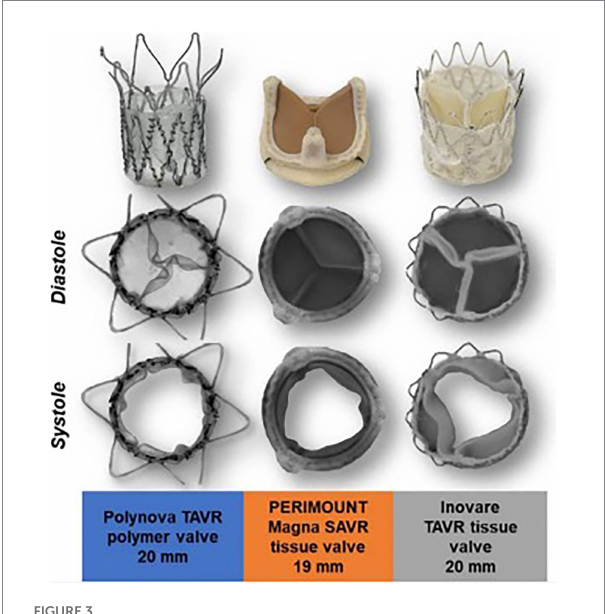
FIGURE 3 Polynova polymer TAVR valve compared with Perimount Magna SAVR and Inovare TAVR tissue valves. Images from in-vitro testing showing valve in peak diastole and